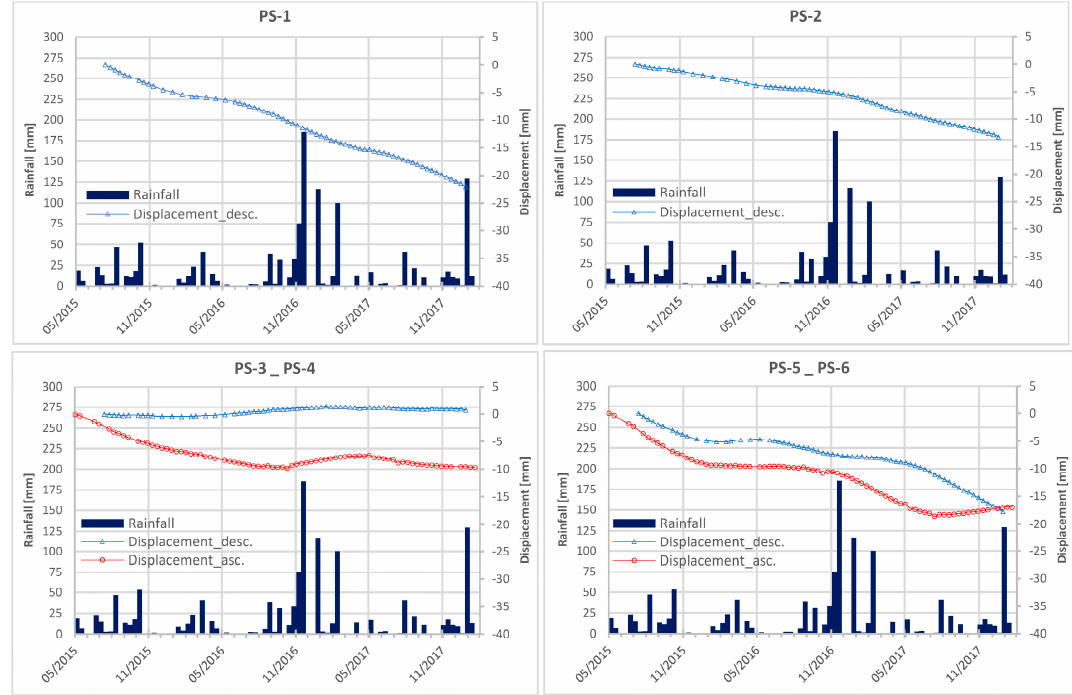
Figure 8. Time series of displacement of points located at the head (PS-1), bottom (PS-3 and PS-4), eastward (PS-2) and westward (PS-5 and PS-6) of the slope, see Figure 7. The displacements are measured along the LoS.